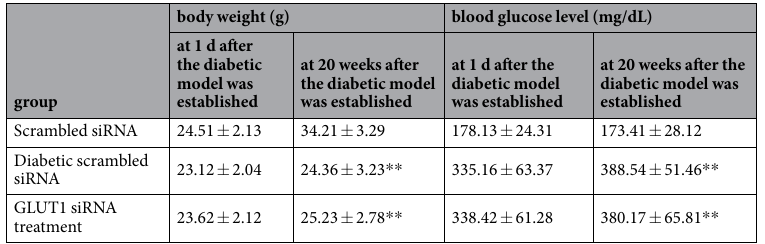
Table 1. Body weight and blood glucose levels of the three groups ( n = 16, x ± S). ** P < 0.01, vs Scrambled